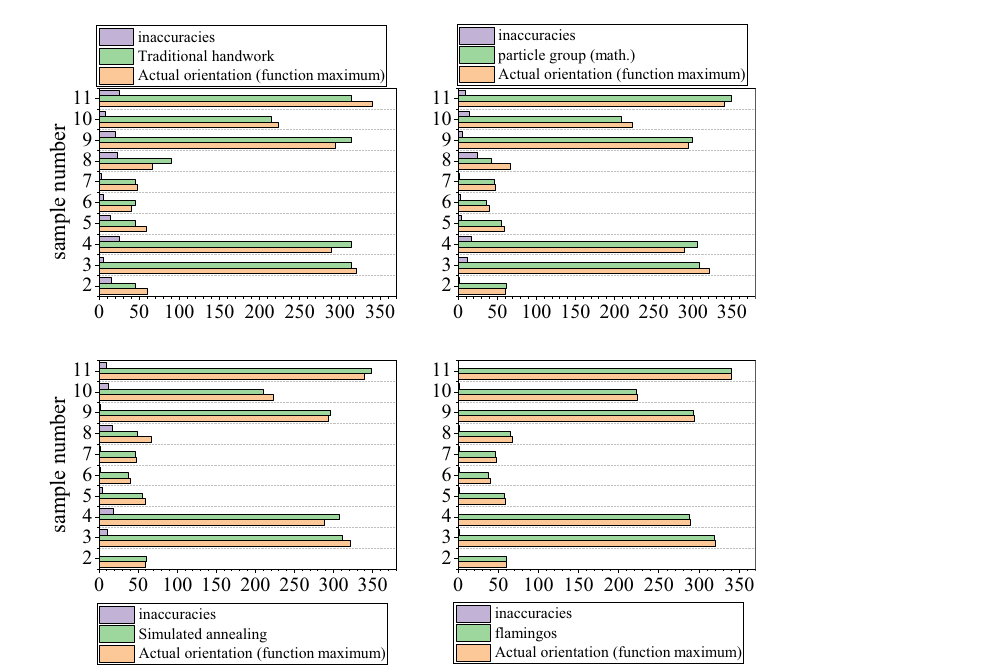
Figure 11. Comparison of search results by